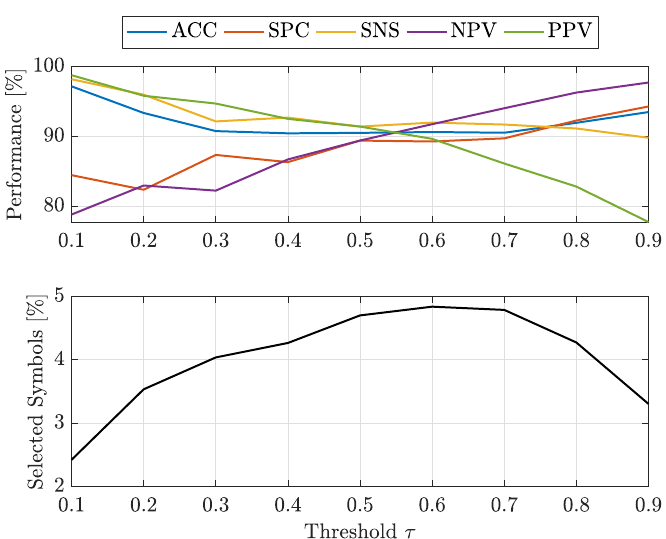
Figure 6. Average Performance on Test Set for Experiment #2 ( (cid:96) 1 -SVM, α =